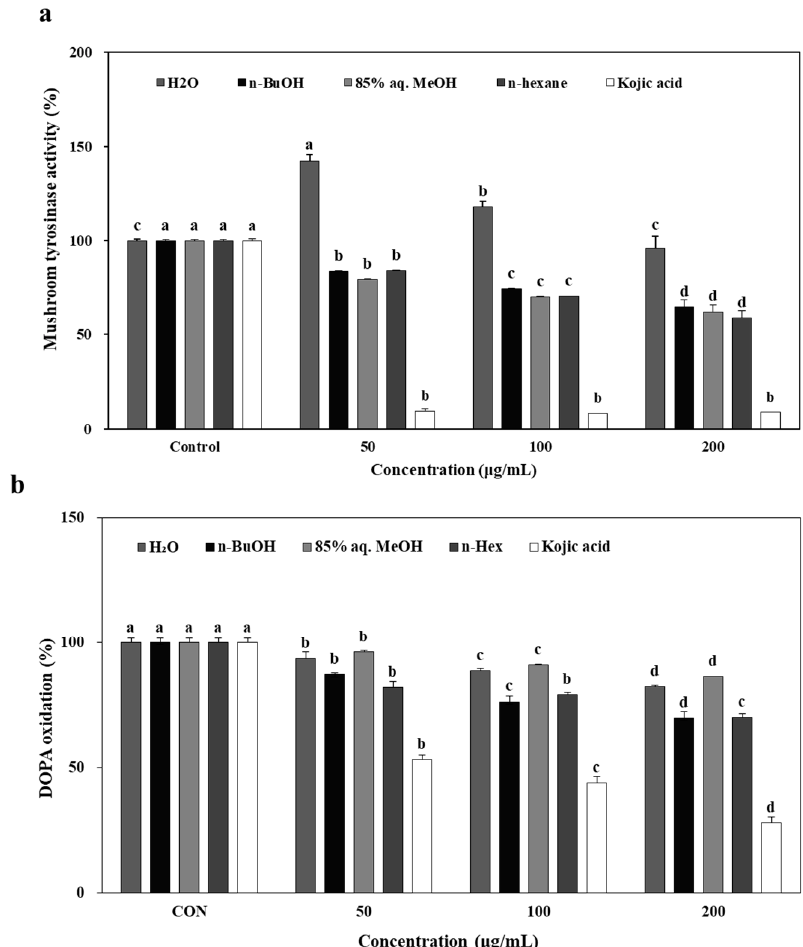
Figure 1. Effect of L. tetragonum solvent-partitioned fractions and kojic acid on mushroom tyrosinase activity ( a ) and DOPA oxidase activity of mushroom tyrosinase ( b ) in vitro. a–d Means with the different letters are significantly different ( p < 0.05) by Duncan's multiple range test among same samples compared to control group.